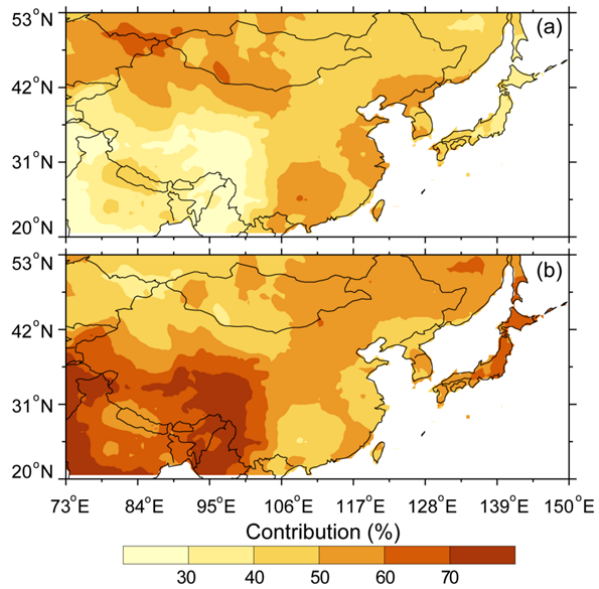
Figure 4. Spatial distribution of contribution of dynamically in- duced (a) and radiatively forced (b) temperatures to raw cold-season temperature from 1902 to 2011 over east Asia.